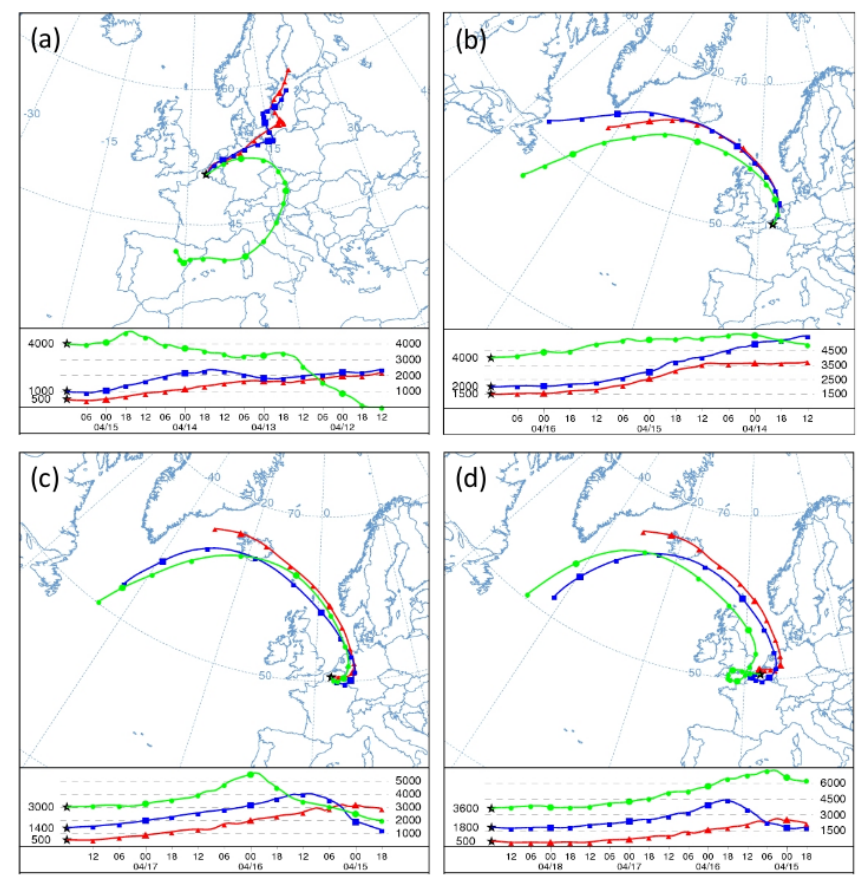
Fig. 4. Backward trajectories for 15 (a) , 16 (b) , 17 (c) and 18 (d) April 2010, ending at Lille (black star). The colors correspond to the different altitudes, given for each figure, below